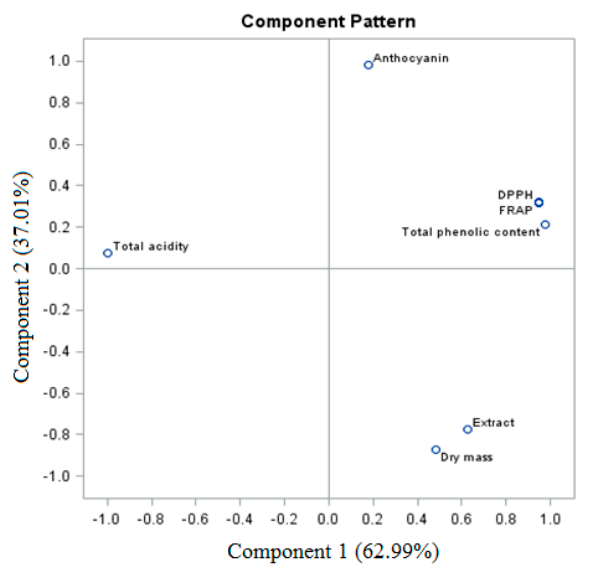
second relationship was shown between dry weight and extract. The third group was the